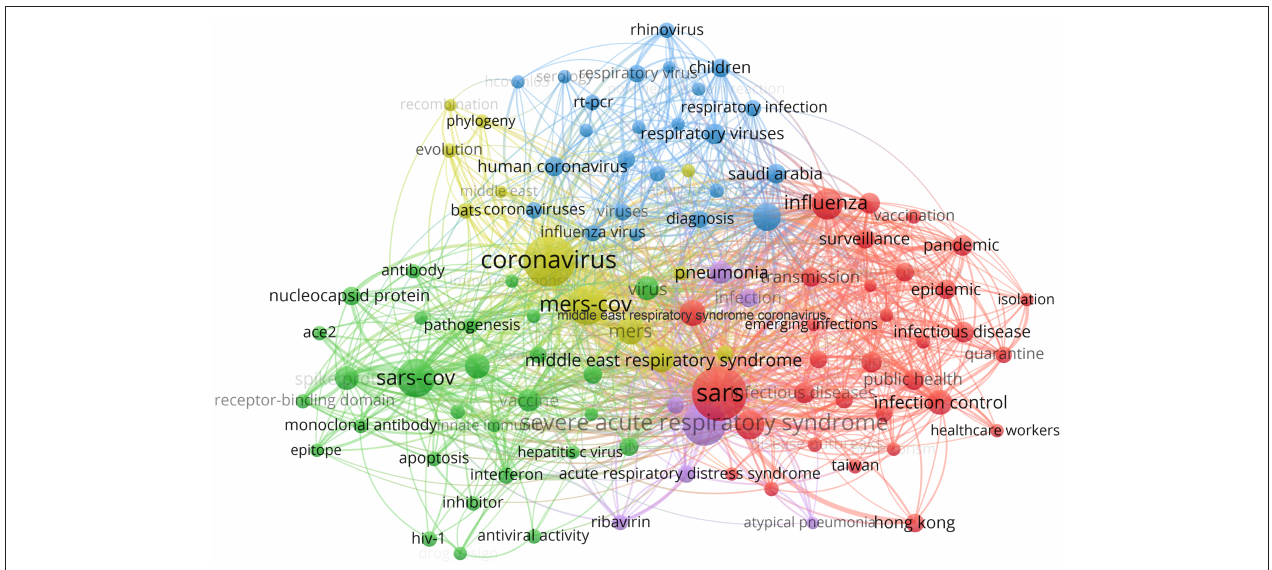
FIGURE 4 | Keyword co-occurrence analysis map. The size of each node indicates the occurrence of the keyword in all 15,207 documents. The thickness of each link indicates the strength of co-occurrence relationship between two keywords. The distance between two nodes indicates the relatedness of the links they each has. Nodes with common attributes are assigned to a color-coded